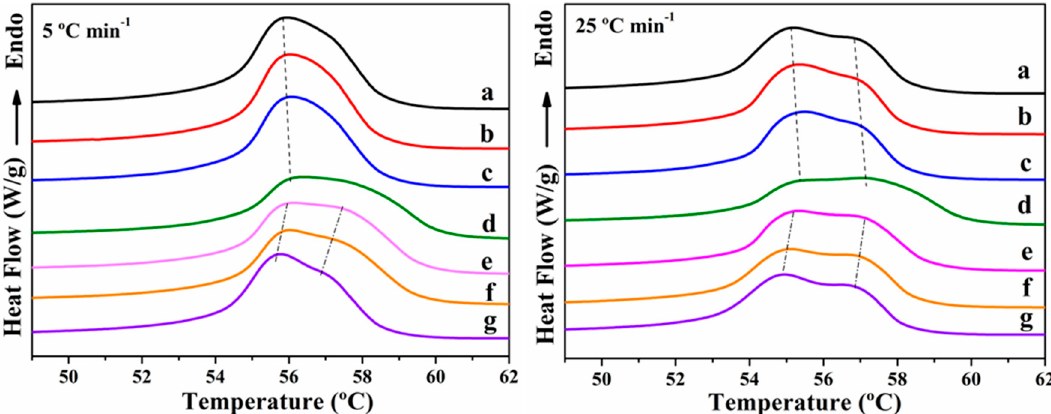
Figure 6. DSC thermograms of melting of ( a ) PCL, ( b ) PCL / APIBPOSS-2, ( c ) PCL / APIBPOSS-5, ( d ) PCL / APIBPOSS-10, ( e ), PCL / APIOPOSS-2 ( f ) PCL / APIOPOSS-5, and ( g ) PCL / APIOPOSS-10 nanocomposites obtained during heating at 10 ◦ C min − 1 after non-isothermal crystallization at the indicated cooling rates.